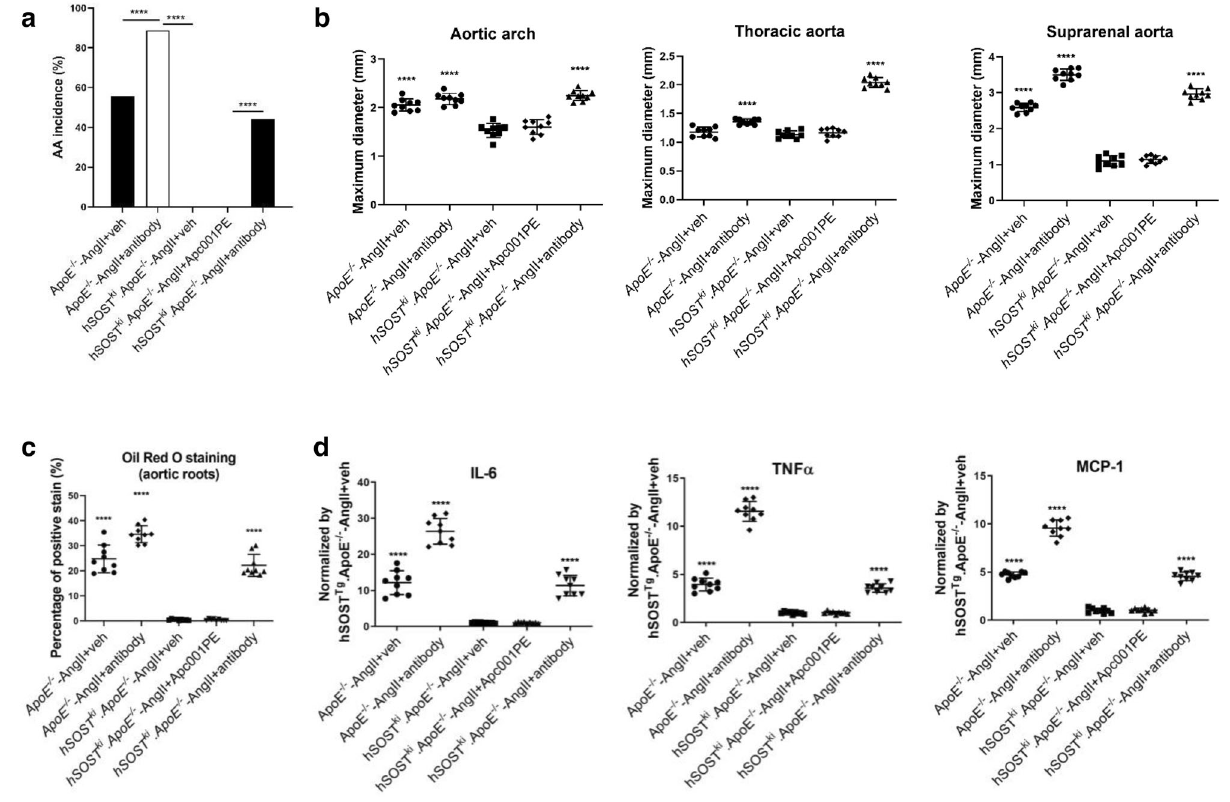
Fig. 6 Determination of whether targeting sclerostin loop3 by the speci fi c in vivo pharmacologic tool Apc001PE in fl uenced the protective effect of overexpressed human sclerostin on the cardiovascular system by evaluating cardiovascular events in hSOST ki .ApoE − / − mice with AngII infusion. ApoE − / − mice or hSOST ki . ApoE − / − mice with AngII infusion were subcutaneously administered vehicle, Apc001PE (12 mg/kg) or humanized therapeutic sclerostin antibody (25 mg/kg) twice weekly for four weeks. After administration, the aortas were harvested for analysis. a The incidence of AA formation. A two-sided chi-square test was performed to determine the difference between groups. **** p < 0.0001 . p < 0.0001 for all comparisons. b Ex vivo measurement of the maximum diameters of the aortic arches (left), thoracic aortas (middle) and suprarenal aortas (right). Aortic arch: p < 0.0001 ( ApoE − / − -AngII + veh), p < 0.0001 ( ApoE − / − -AngII + antibody), p < 0.0001 ( hSOST ki . ApoE − / − -AngII + antibody); thoracic aorta:, p < 0.0001 ( ApoE − / − - AngII + antibody), p < 0.0001 ( hSOST ki . ApoE − / − -AngII + antibody); suprarenal aorta: p < 0.0001 ( ApoE − / − -AngII + veh), p < 0.0001 ( ApoE − / − -AngII